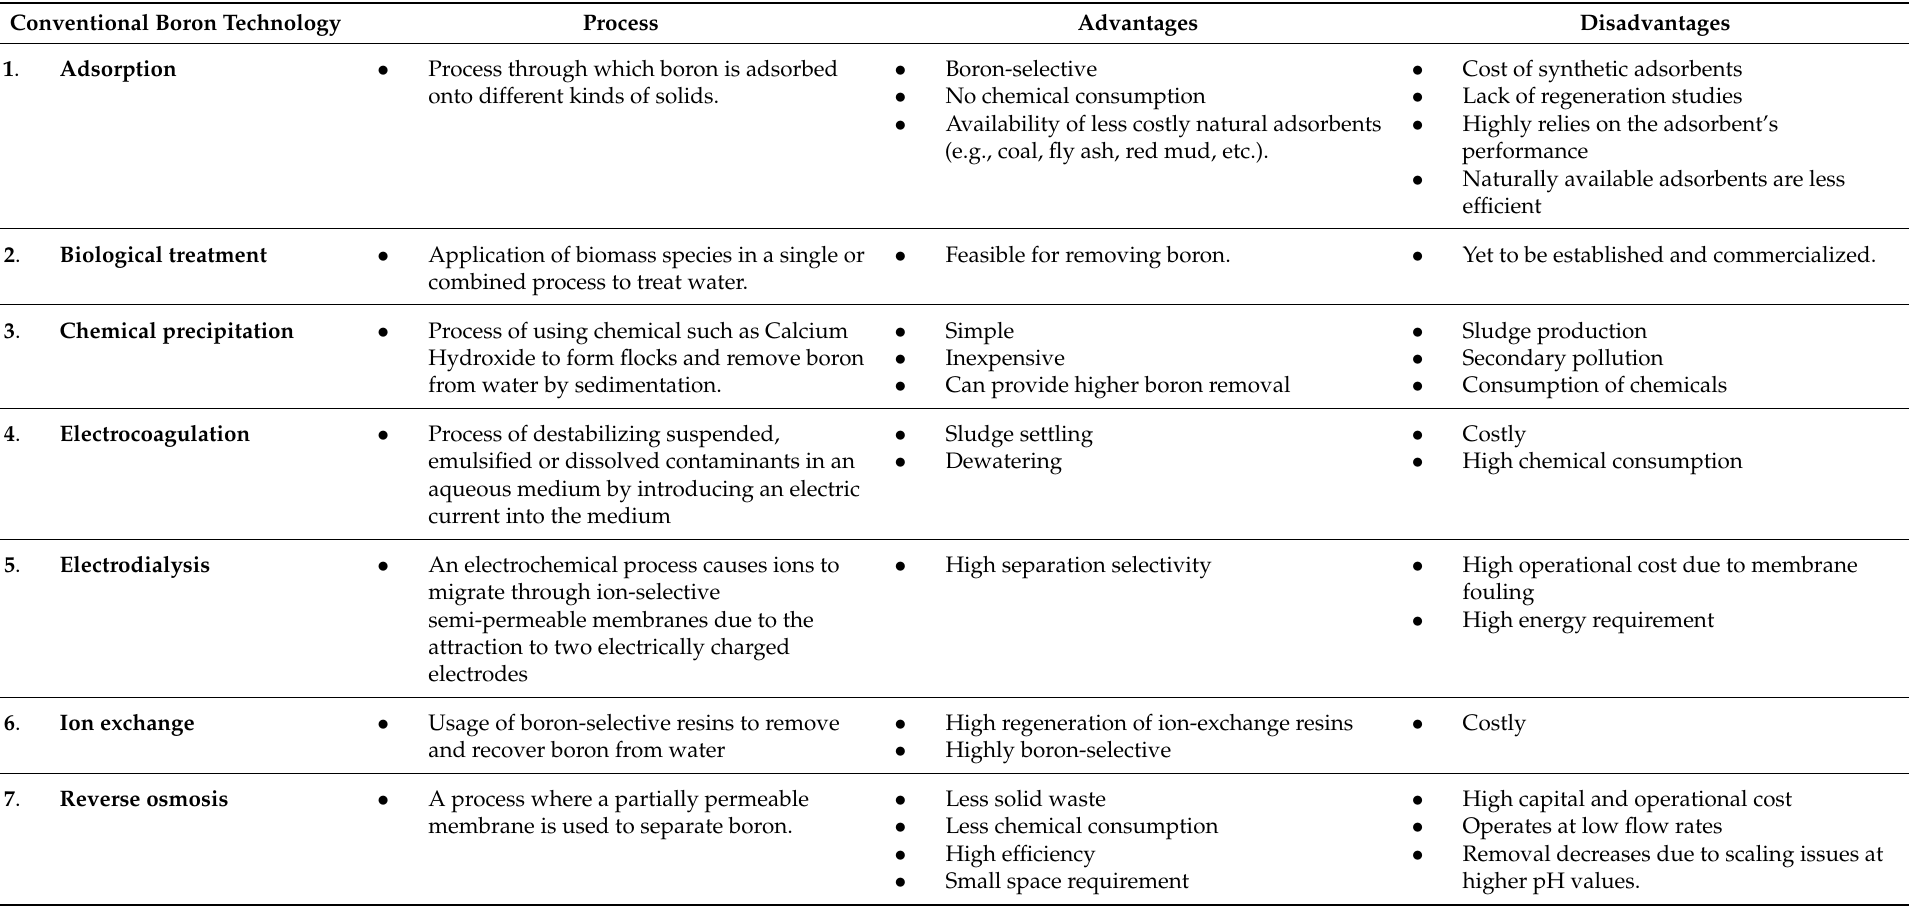
Table 2. Advantages and disadvantages of different boron-removing technologies